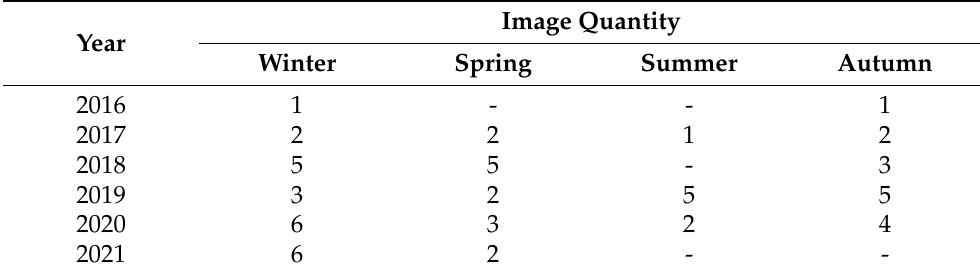
Table 1. Sentinel-2 data obtained in the four seasons from 2016 to